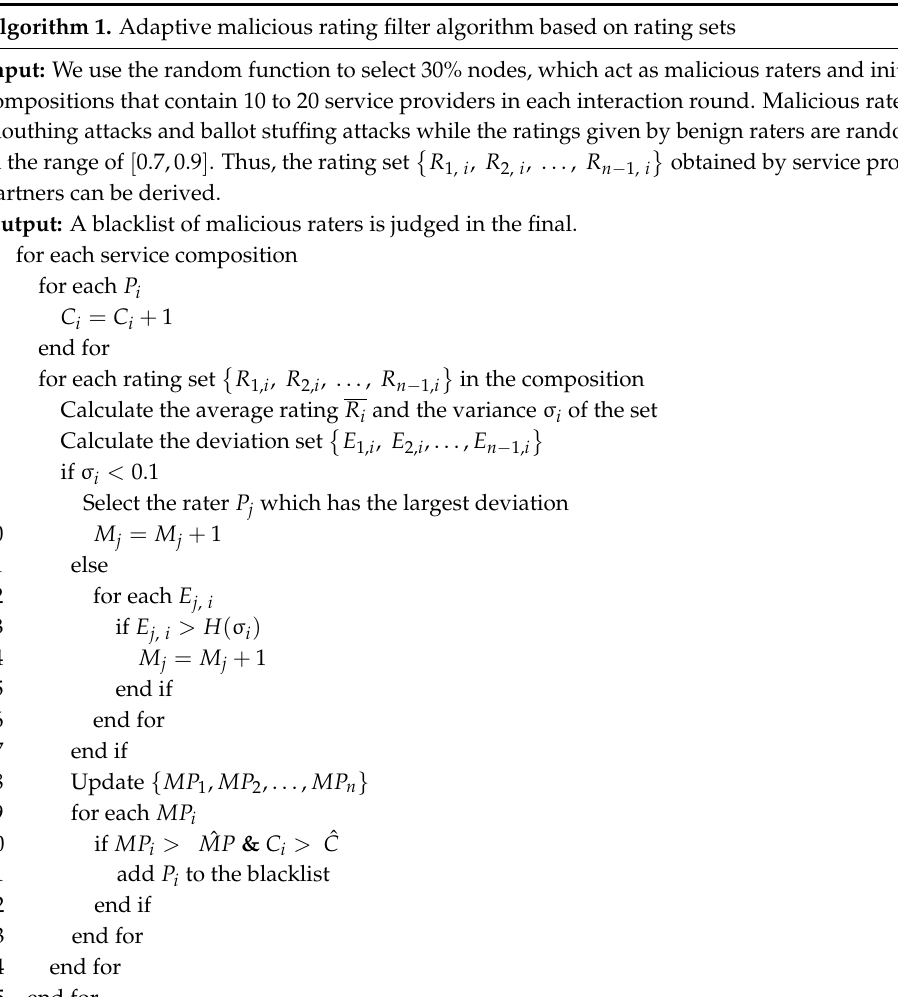
Algorithm 1. Adaptive malicious rating filter algorithm based on rating